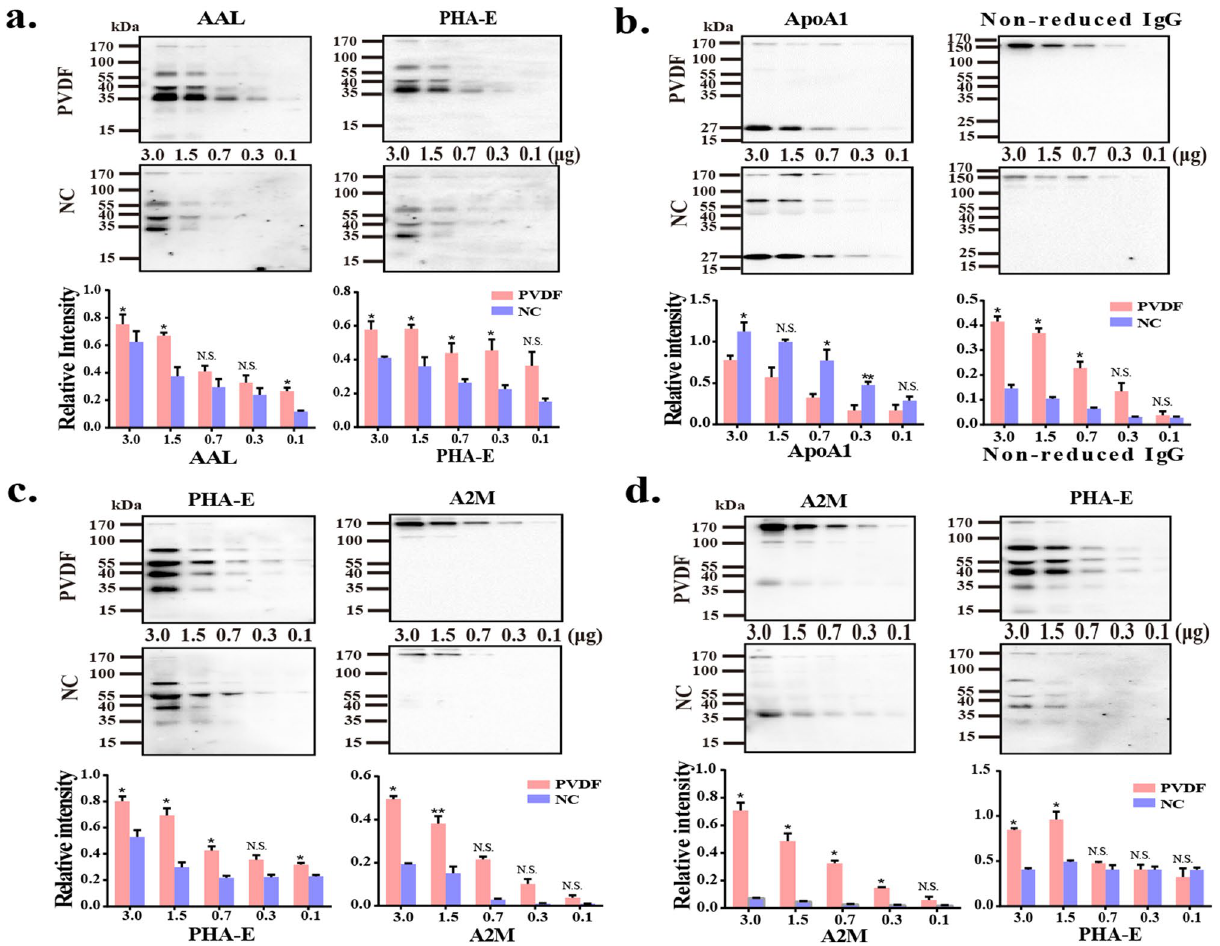
Figure 5. Comparison of the re-probed ability of PVDF membrane and NC membrane. The pooled sera proteins (3.0, 1.5, 0.7, 0.3 and 0.1 μg) were separated by 8% SDS-PAGE, and transferred to PVDF membranes (up) and NC membrane (down), respectively. ( a ) Staining with AAL and then re-probed with PHA-E; ( b ) staining with ApoA1 and then re-probing with IgG; ( c ) Staining with PHA-E and then re-probing with A2M; ( d ) staining with A2M and then re-probing with PHA-E. Band intensities were statistically analyzed (n = 3 individual experiments) and compared using Image Lab software (Bio-Rad Laboratories) and GraphPad Prism version 6. Pink bar, PVDF membrane; Blue bar, NC membrane. Band intensities were analyzed *Significantly different p < 0.05, ** p < 0.01. N.S., not significant. All values are means ± S.E. (error